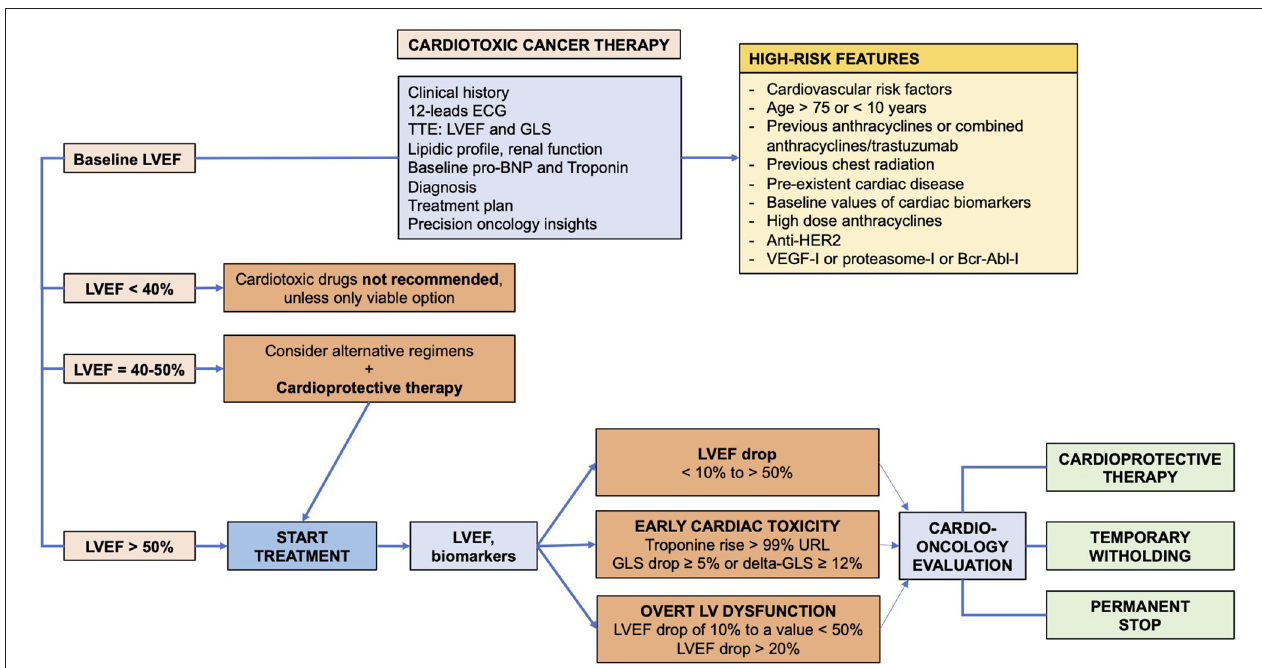
FIGURE 1 | Algorithm for diagnosis and prevention of cardiac toxicity in cancer patients receiving cardiotoxic